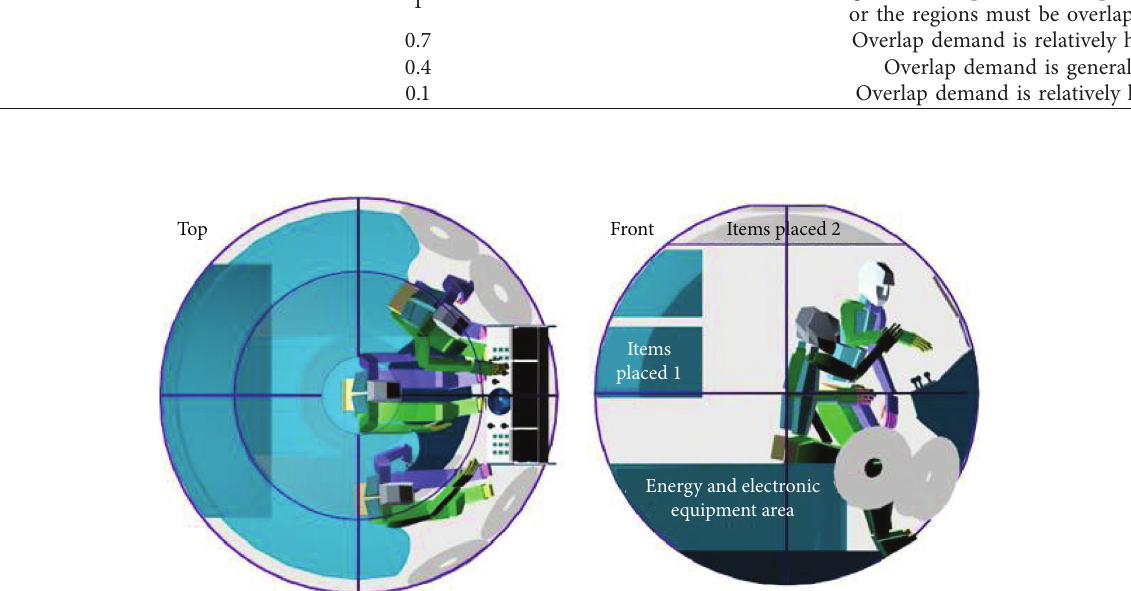
Figure 6: Abstract reconstruction and optimization of overlapped space for submersible pilots in the spherical cabin.